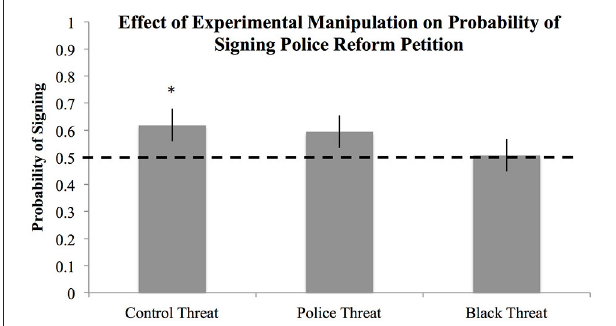
FIGURE 2 | Probability of signing a petition in support of police reform as a function of threat condition. * Indicates significant deviation from chance ( p < 0.50 ), error bars represent standard